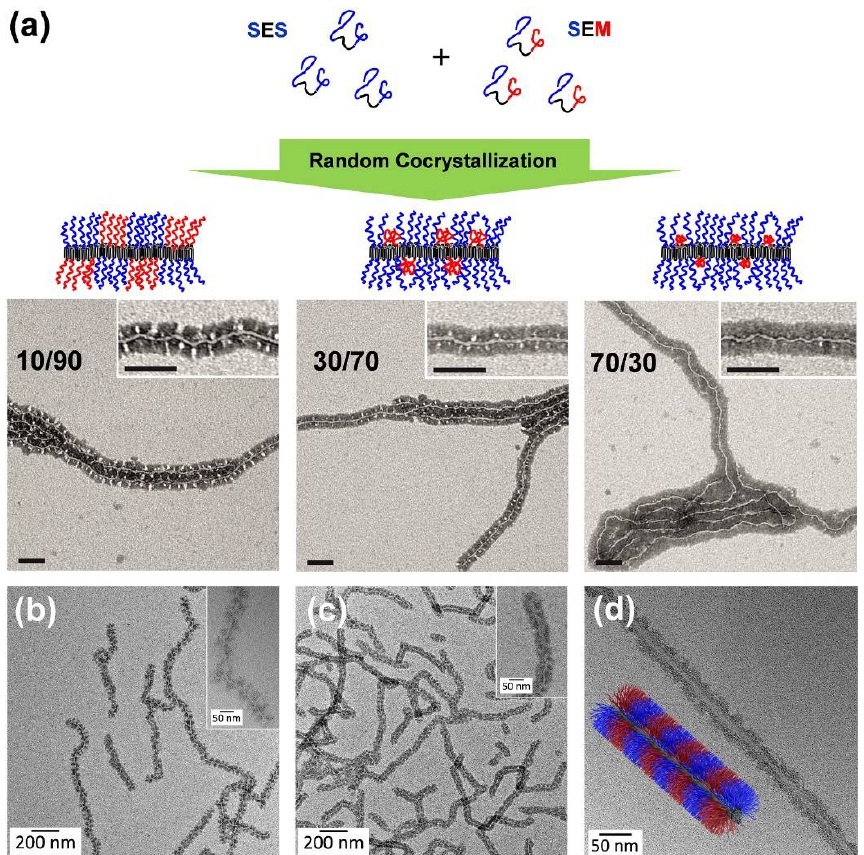
Figure 6. ( a ) Random co-crystallization of a SES triblock copolymer and a SEM triblock terpolymer, in order to tune the size of the corona patches. TEM images of patchy wCCMs obtained by co-crystallization of S 380 E 880 S 390 with S 340 E 700 M 360 in THF (subscripts denote the respective average degrees of polymerization), revealing a decreasing size of the bright-appearing PMMA corona patches with an increasing amount of S 380 E 880 S 390 (scale bars: 100 nm). TEM images of patchy ( b ) S 415 E 830 DMA 420 and ( c ) S 660 E 1350 DMA 350 wCCMs (DMA: N,N -dimethylaminoethyl methacrylamide), as well as ( d ) 1D patchy hybrids with a CNT core and a patchy PS/PMMA corona prepared by ultrasound-assisted, non-covalent grafting of an SEM triblock terpolymer onto CNTs. For all samples, PS was selectively stained with RuO 4 vapor and appears dark. ( a ) Reproduced from [136] with permission of Elsevier, ( b , c ) reprinted from [138] with permission of RSC, and ( d ) reproduced from [139] with permission of ACS.